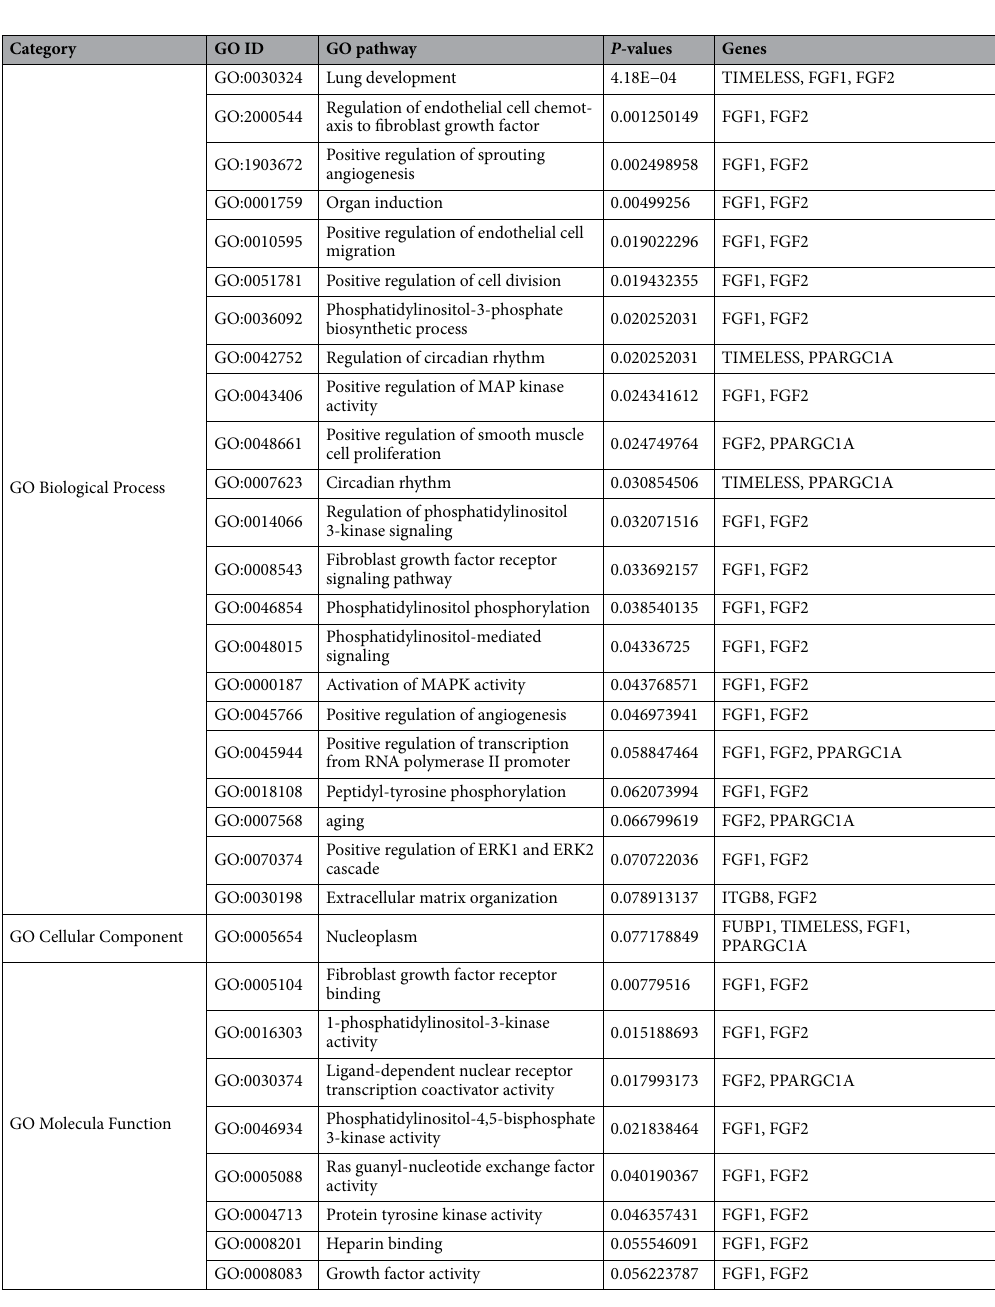
Table 2. GO enrichment analysis of common DEGs.